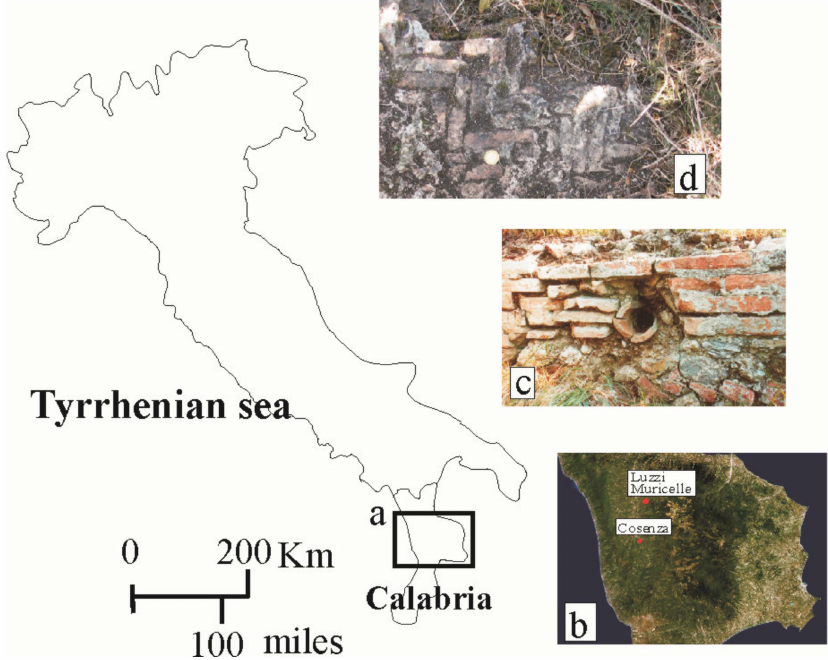
Figure 1. ( a ) Italy—Calabria; ( b ) Muricelle archaeological site; photos of ( c ) ruins of wall and ( d ) opus spicatum floor of the Roman villa